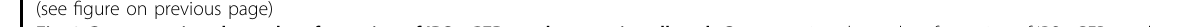
Fig. 3 Concentration-dependent formation of IRS1-GFP condensates in cells. a , b Concentration-dependent formation of IRS1-GFP condensates in U2OS cells. Various amounts of IRS1-GFP plasmid were transfected into cells (1× IRS1-GFP indicates 0.4 μ g plasmid DNA per well in a 12-well plate) to achieve increased expression levels of IRS1-GFP protein in U2OS cells. The formation of IRS1-GFP condensates was detected via fl uorescence confocal microscope ( a ), and the expression levels of IRS1-GFP and endogenous IRS1 were determined via immunoblotting ( b ). Scale bar, 10 μ m. c , d Formation of condensates of IRS1-GFP or IRS1 8Y/F -GFP or IRS1 G972R -GFP in HEK293T cells. The 8 tyrosine residues whose phosphorylation is dependent on IR were mutated to non-phosphorylatable phenylalanine residues on IRS1 8Y/F -GFP. c Representative images. d Quanti fi cation of IRS1- GFP condensates per cell. n = 113 – 156. Statistical analyses were carried out via one-way ANOVA. n.s., not signi fi cant. Scale bar, 10 μ m. e , f FRAP analysis of wild-type or mutant IRS1-GFP condensates in U2OS cells. e Quanti fi cation of FRAP analyses. f Representative images. Scale bar, 10 μ m. The condensates subjected to FRAP were indicated with white arrows. The ROI intensity was normalized to the value before photo-bleaching and given as the means ± SEM. n = 34 – 43. Statistical analyses were carried out via one-way ANOVA. * p < 0.05 (IRS1 G972R -GFP vs. WT IRS1-GFP, IRS1 G972R -GFP vs IRS1 8Y/F -GFP). g The material exchange between IRS1-GFP condensates and cytoplasm was examined by FRAP analysis in U2OS cells. The whole condensate of IRS1-GFP was photo-bleached and monitored subsequently. Scale bar, 10 μ m. h Effects of 1,6-hexanediol on IRS1-GFP condensates. 1,6-hexanediol (5%) was added to U2OS cells, and IRS1-GFP condensates were monitored subsequently. Scale bar, 10 μ